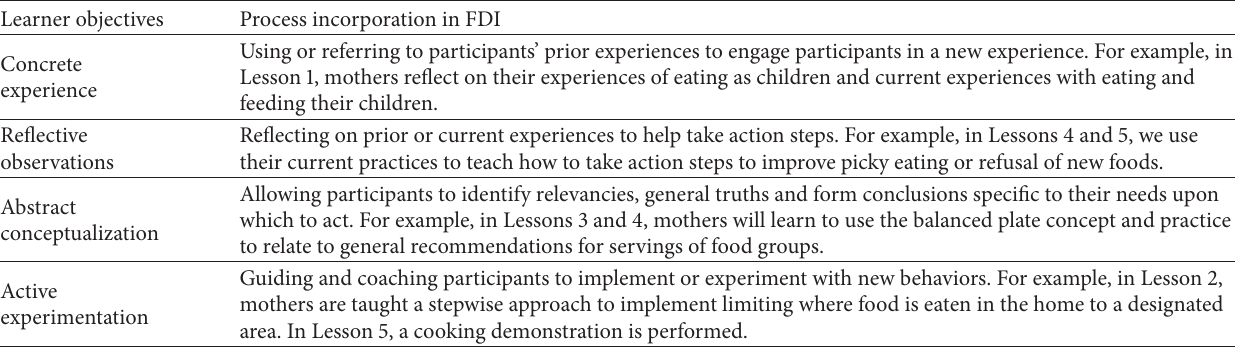
Table 3: The Feeding Dynamic Intervention learner objectives and processes (Study 2).